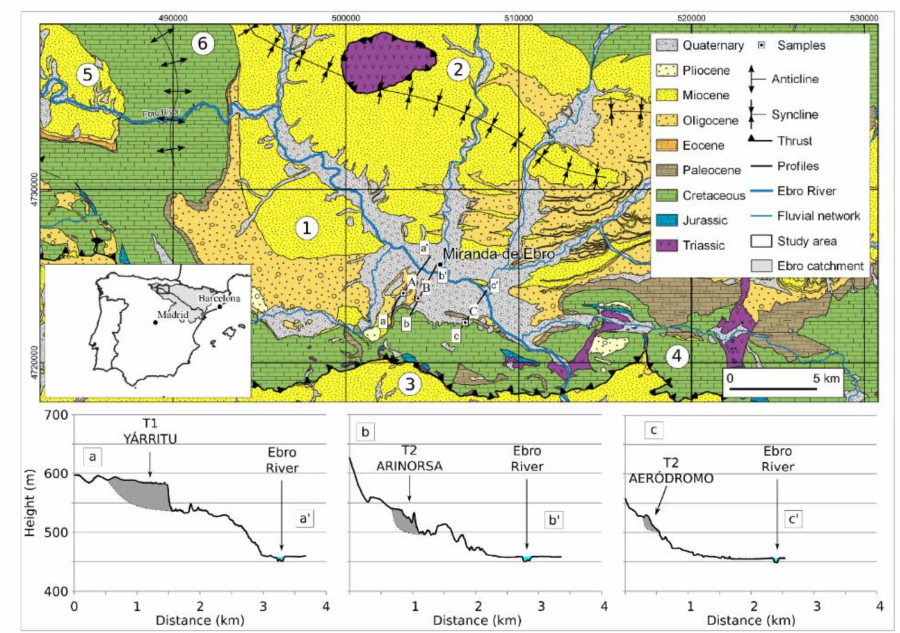
Figure 1. Geological map of Miranda basin and surroundings: (1) Miranda basin; (2) Miranda– Treviño syncline (uplifted central axis); (3) Ebro foreland basin; (4) Obarenes–Sierra Cantabria thrust; (5) Tobalina Valley; (6) Sobr ó n anticline. Bottom left inset shows location of study area within Ebro River catchment (gray zone), situated in the northern Iberian Peninsula. Below, cross-sections of the analyzed terraces: A, Monte Miranda–Yarritu; B, Monte Miranda–Arinorsa; C, Aer ó